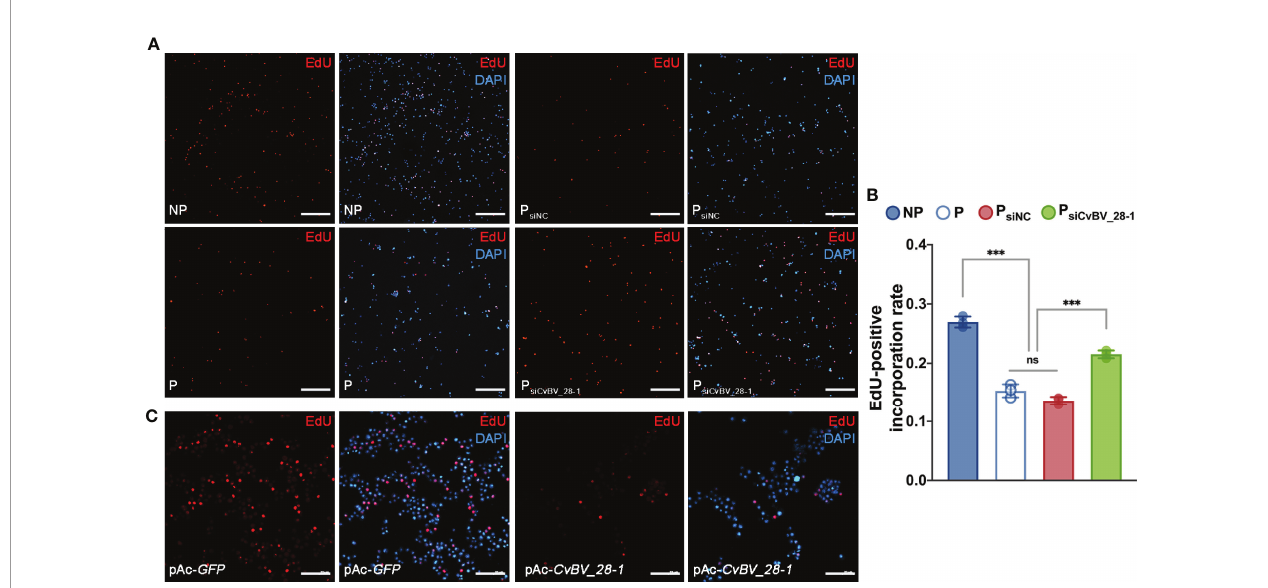
FIGURE 6 | CvBV_28-1 suppresses proliferation rate of hemocytes in parasitized P. xylostella and S2 cells. (A) EdU incorporation assay of hemocytes in siCvBV_28-1-injected P. xylostella larvae (P siCvBV_28-1 ) 12 h post-parasitization. Nonparasitized P. xylostella larvae (NP), parasitized P. xylostella larvae (P) and siNC- injected parasitized P. xylostella larvae (P siNC ) served as controls. EdU was stained with EdU-Alexa 594 (red), and the nuclei were labeled with DAPI (blue). Representative images from three independent replicates are displayed. Scale bars: 50 µm. (B) Quanti fi cation of EdU staining in hemocytes of siCvBV_28-1-injected P. xylostella larvae (P siCvBV_28-1 ) 12 h post-parasitization. Nonparasitized P. xylostella larvae (NP), parasitized P. xylostella larvae (P) and siNC-injected parasitized P. xylostella larvae (P siNC ) served as controls. Three independent biological replicates were performed and shown as dots. Data are presented as the mean values ± SD. Differences between groups were analyzed by one-way ANOVA with Tukey ’ s multiple comparisons test (***p < 0.001; ns: not signi fi cant). (C) EdU incorporation assay of S2 cells transfected with pAc- CvBV_28-1 and pAc- GFP . EdU was stained with EdU-Alexa 594 (red), and the nuclei were labeled with DAPI (blue). Representative images from three independent replicates are displayed. Scale bars: 50